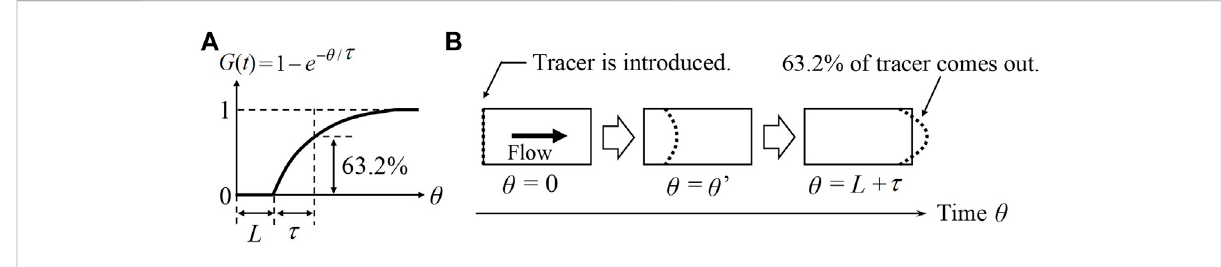
FIGURE 9 (A) Step response curve of G ( s ) and (B) guideline for determination of τ